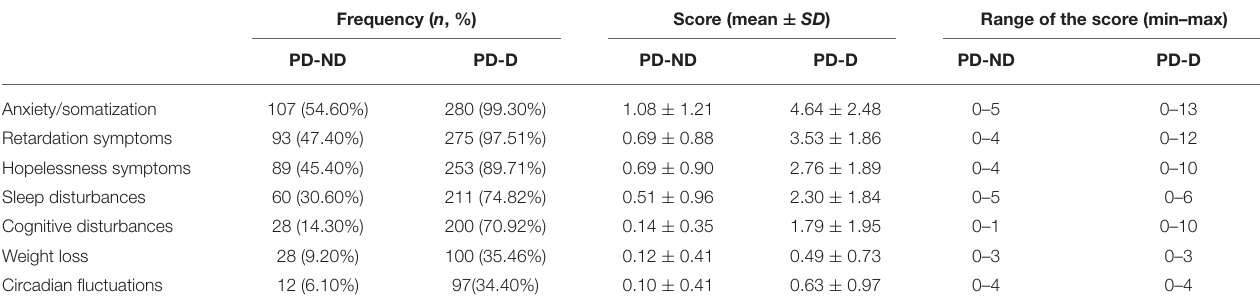
TABLE 1 | Assessment of each sub-factor of HAMD for PD-D and PD-ND